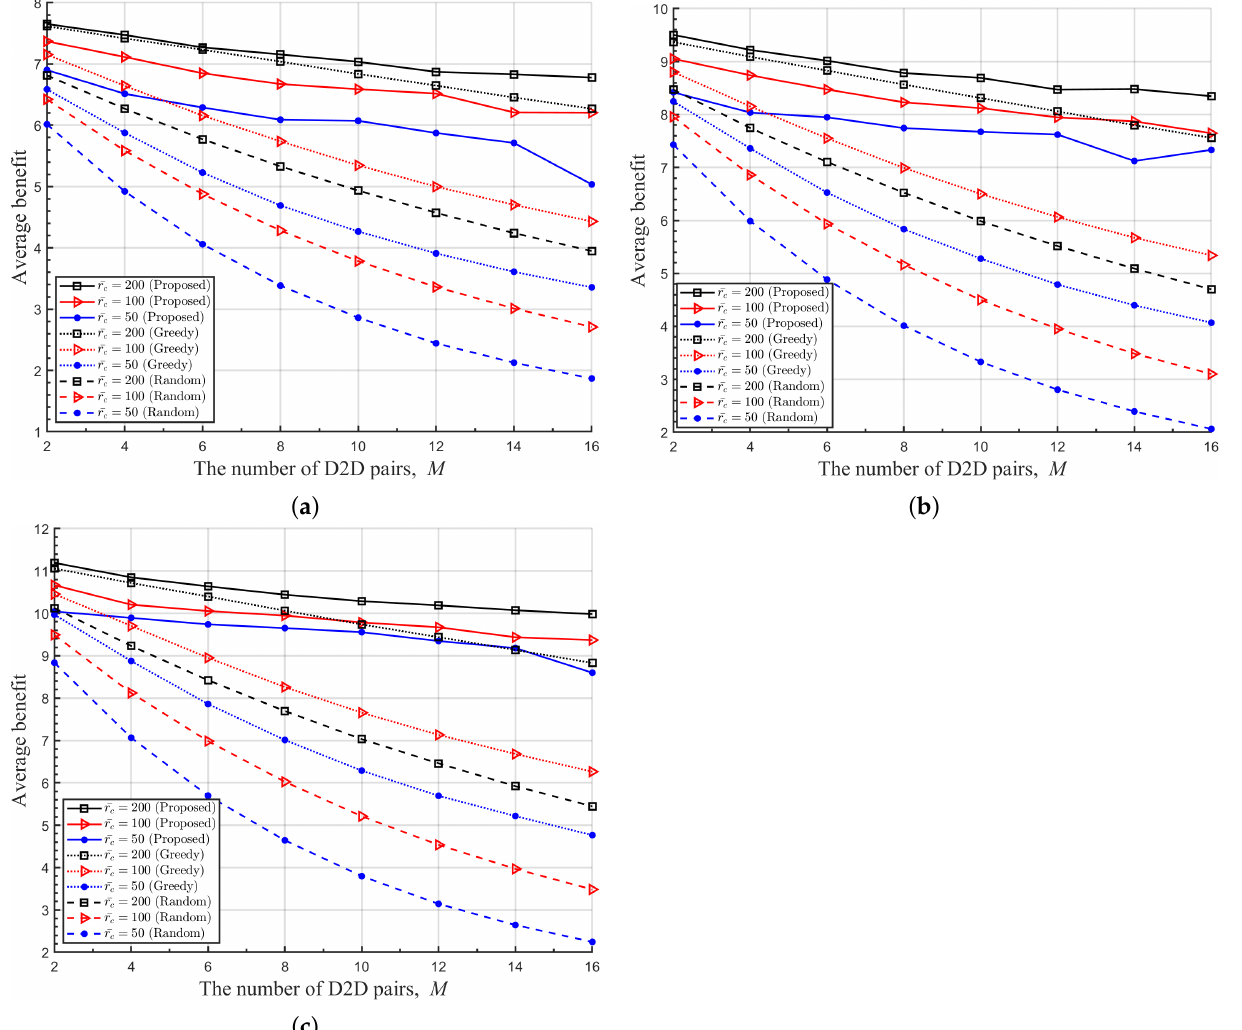
Figure 6. Average benefit of the proposed and other RA schemes with respect to M for various ¯ r c